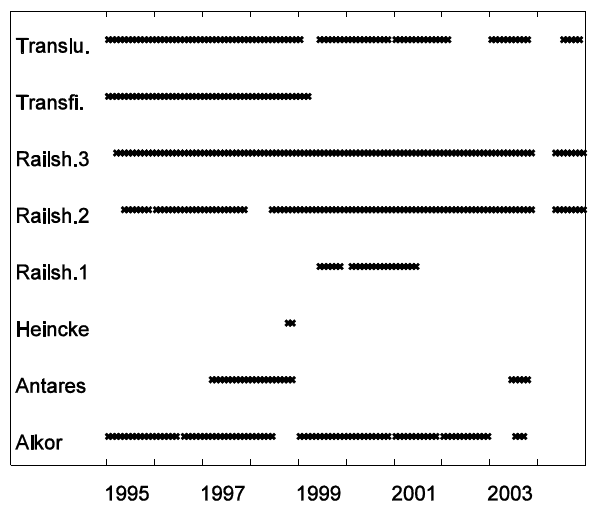
Figure 1. Ships and periods of measurements. Translubeca, Transfinlandia, Railship 1, 2, and 3, and Antares are merchant ships, Heincke and Alkor are research vessels.